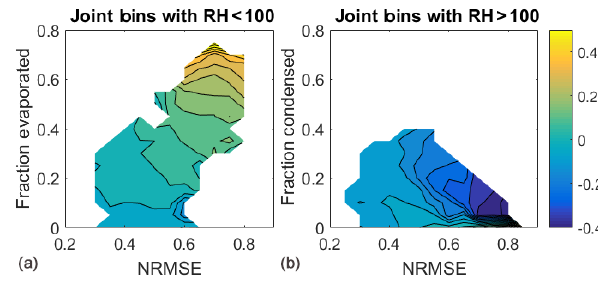
Figure 7. For each joint S , N t , and D bin, the mean NRMSE and mean fraction of mass evaporated or condensed was calculated. Each panel shows the relationship between the mean NRMSE, mean adjusted ln(ratio) (colors), and (a) mean fraction of mass evaporated or (b) mean fraction of mass condensed. Joint bins from all simulation pairs are included in the mean adjusted ln(ratios) that are